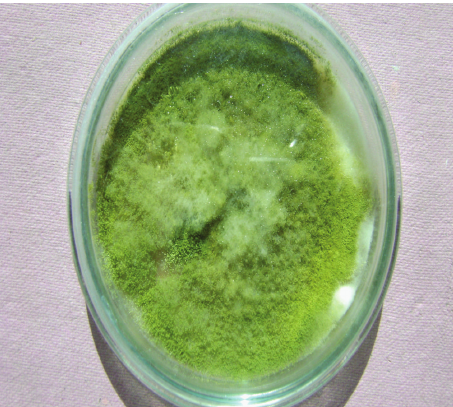
Figure 3: SDA plate on the 5th day showing white, cottony, flu ff y growth of Zygomycetes species superimposed on powdery, granular growth of Aspergillus species.